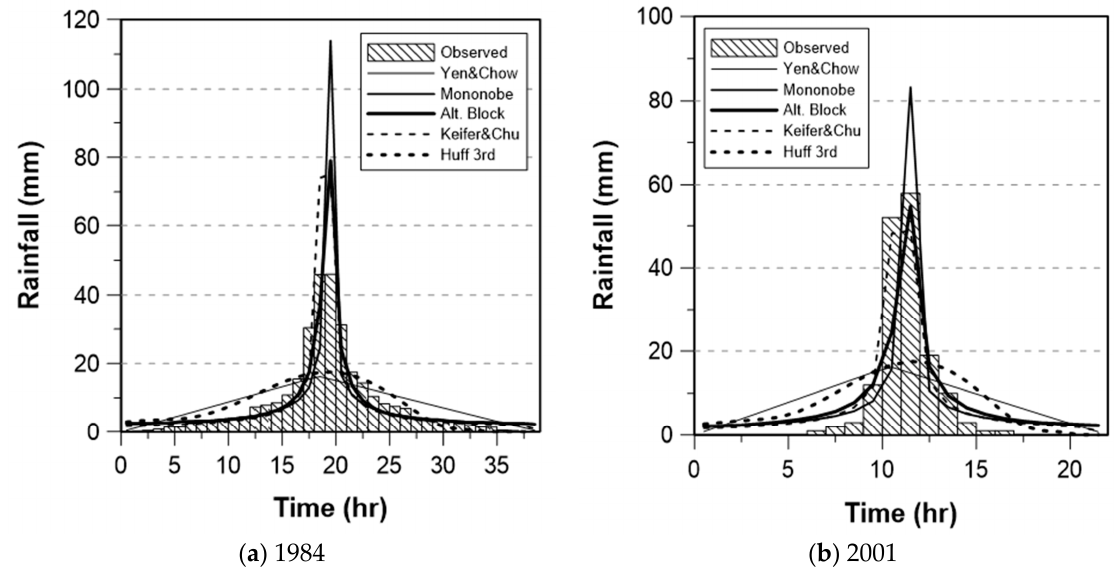
Figure 4. As for Figure 2, but for Case 3.